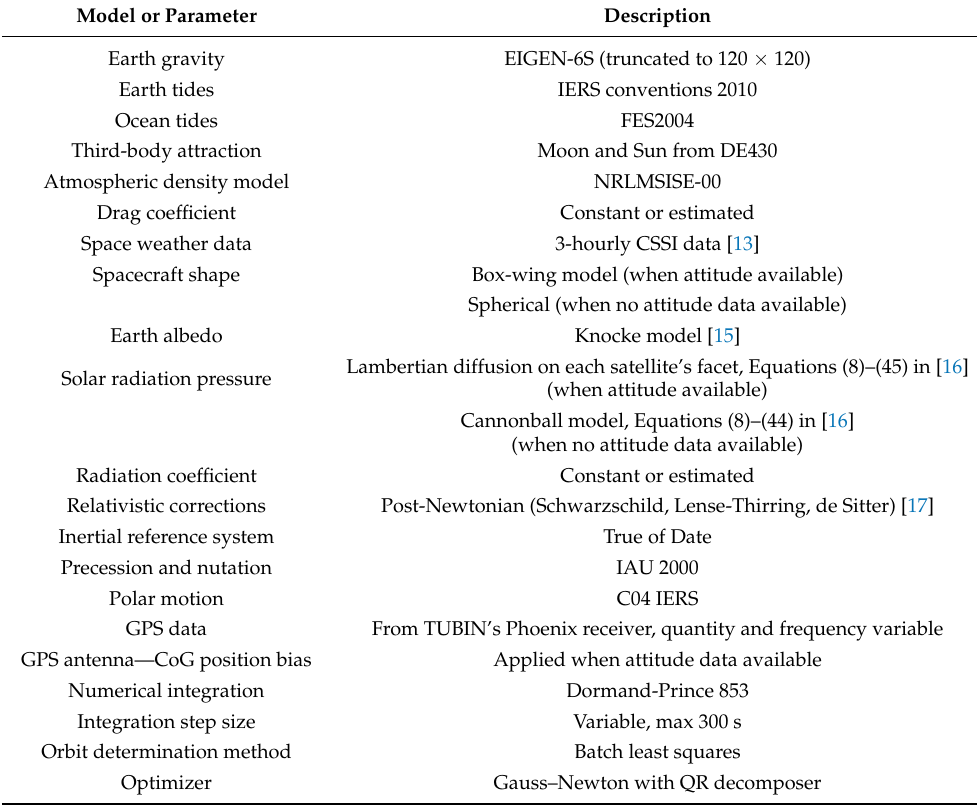
Table 3. Force models and parameters for TUBIN orbit